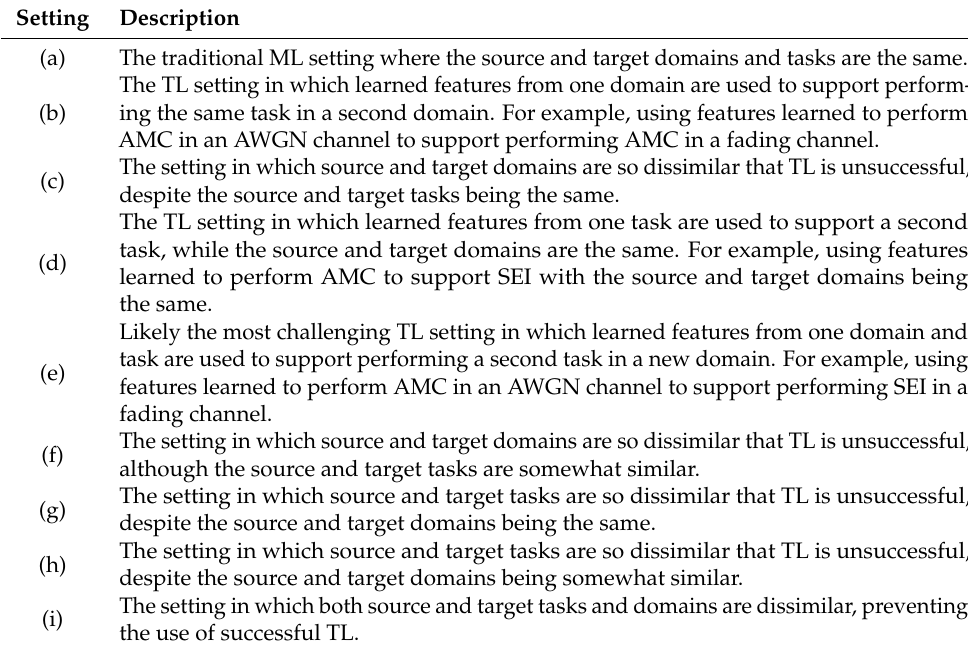
Table 2. The settings that describe points (a–i) on the two-dimensional spectrum of “similarity” between source and target domains and tasks shown in Figure